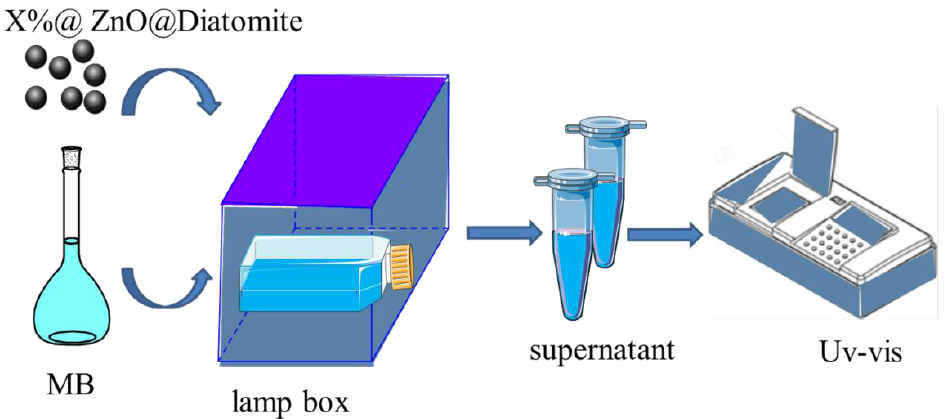
Scheme 3. Flow chart of photocatalyst degradation of MB.